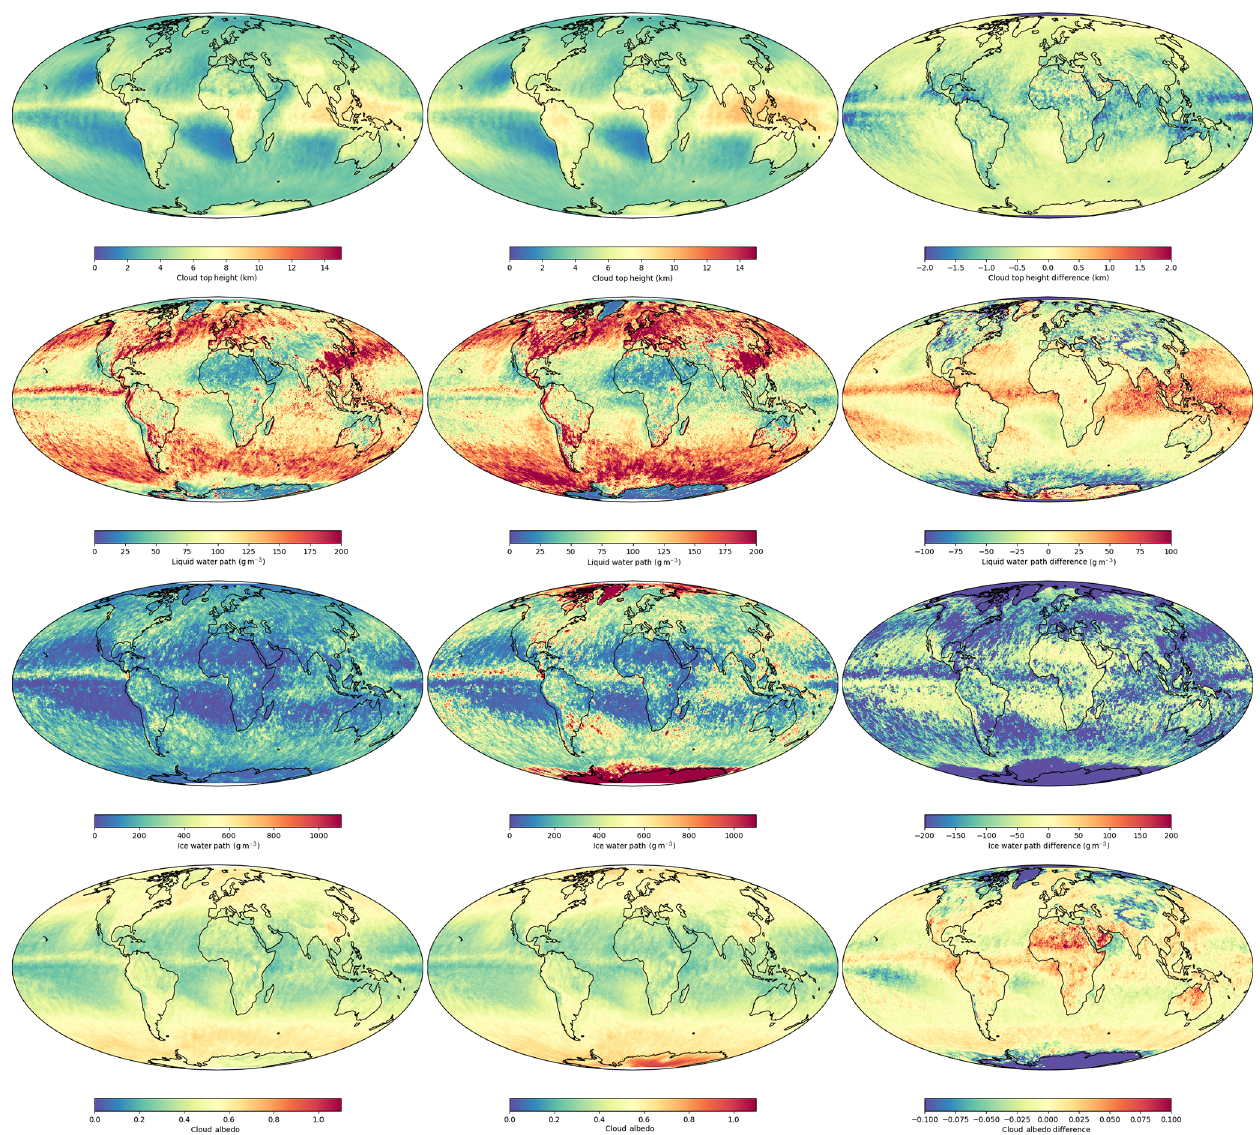
Figure 2. As in Fig. 1 but for cloud top height (CTH), liquid water path (LWP), ice water path (IWP) and cloud albedo